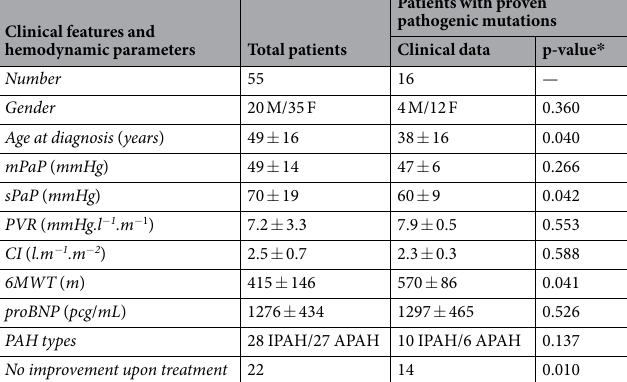
Table 1. Clinical features and hemodynamic parameters of patients included in this study. Values are expressed as mean ± standard deviation; F: female, M: male; mPaP: mean pulmonary artery pressure; sPaP: systolic pulmonary artery pressure; PVR: pulmonary vascular resistence; CI: cardiac index; 6MWT: 6 minute walking test; IPAH: idiopathic pulmonary arterial hypertension; APAH: associated pulmonary arterial hypertension. * Clinical features and hemodynamic parameters among patients with pathogenic changes in the BMPR2 gene and without.